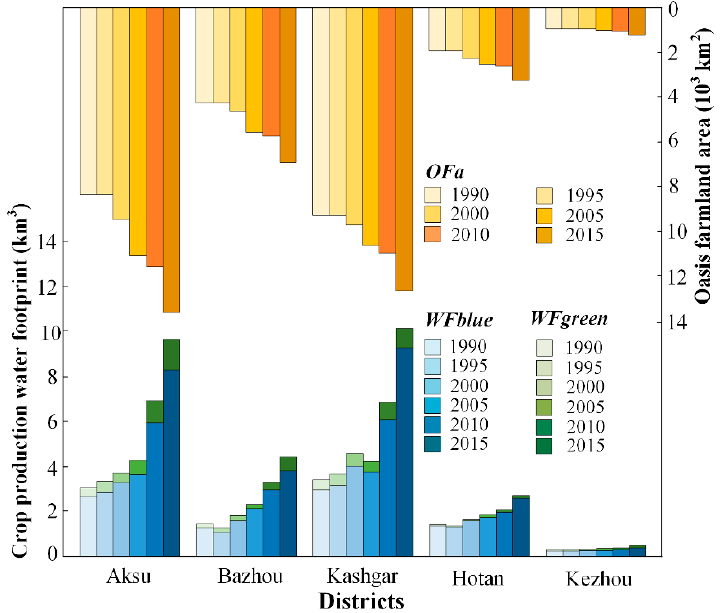
Figure 2. Recent trends in crop production water footprint and farmland area in each district of the Tarim River Basin (TRB) .